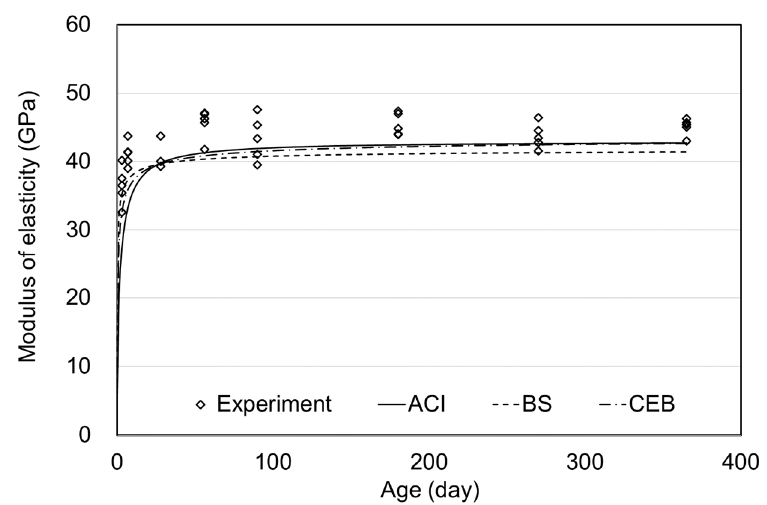
Figure 12. Elastic modulus of moist curing.